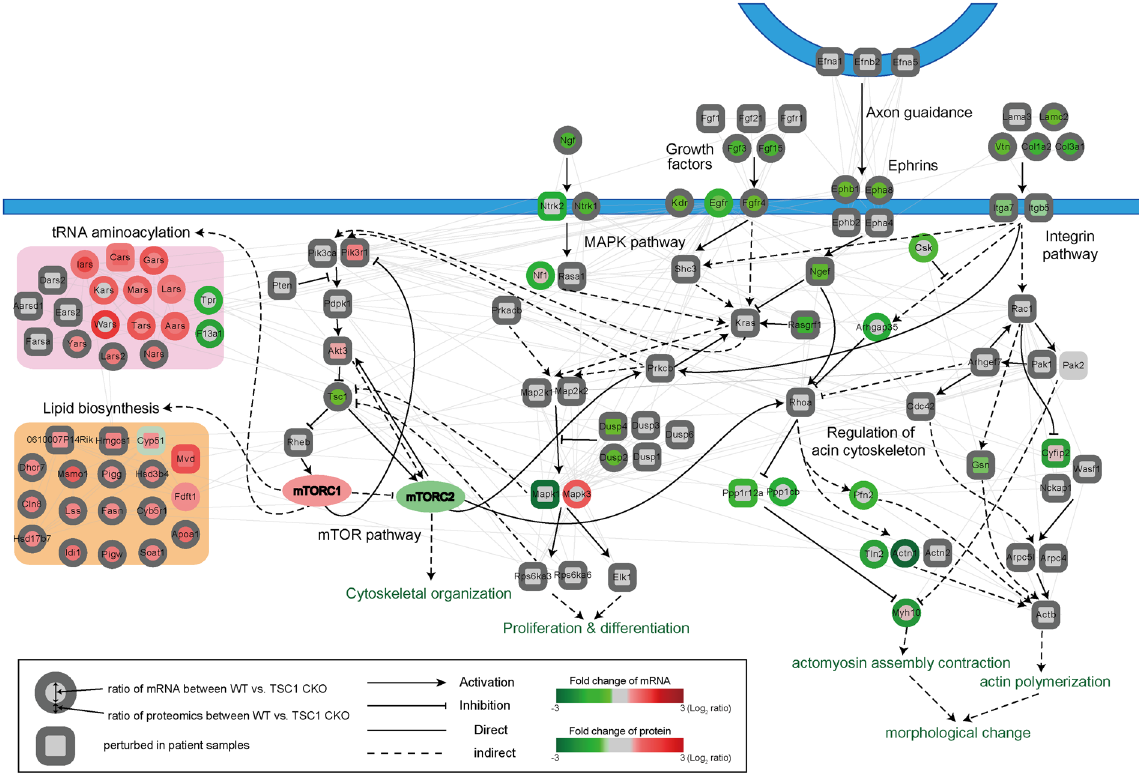
Figure 4. Network model describing association of hyperactivated mTOR signaling with developmental and morphological defects in forebrains. Node colors represent up- (red) and down-regulation (green) of the corresponding genes (center color) and proteins (boundary color) in TSC1 CKO samples compared to WT. The color bar denotes the gradient of log 2 -fold-changes between TSC1 CKO and WT. Edges represent protein-protein interactions (gray) collected from the five interactome databases (Materials and Methods) and activations (arrows) and inhibition (inhibition symbols) obtained from the KEGG pathway database. Solid and dotted lines indicate direct and indirect activation/inhibition, respectively. Plasma membranes are denoted in